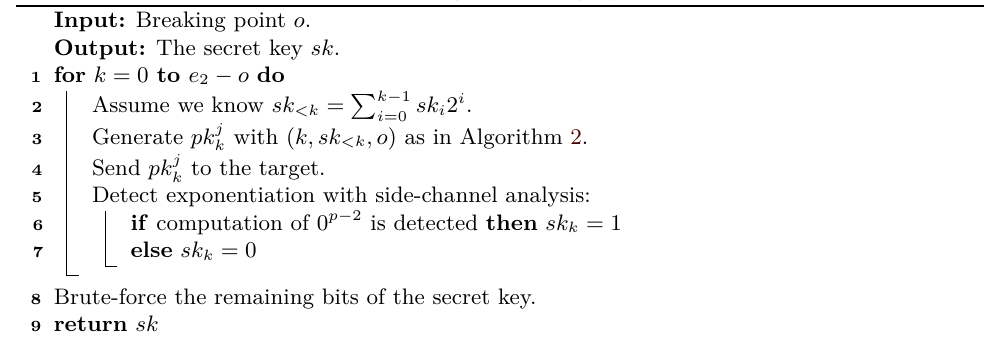
Algorithm 4: Attack scenario relating to the isogeny